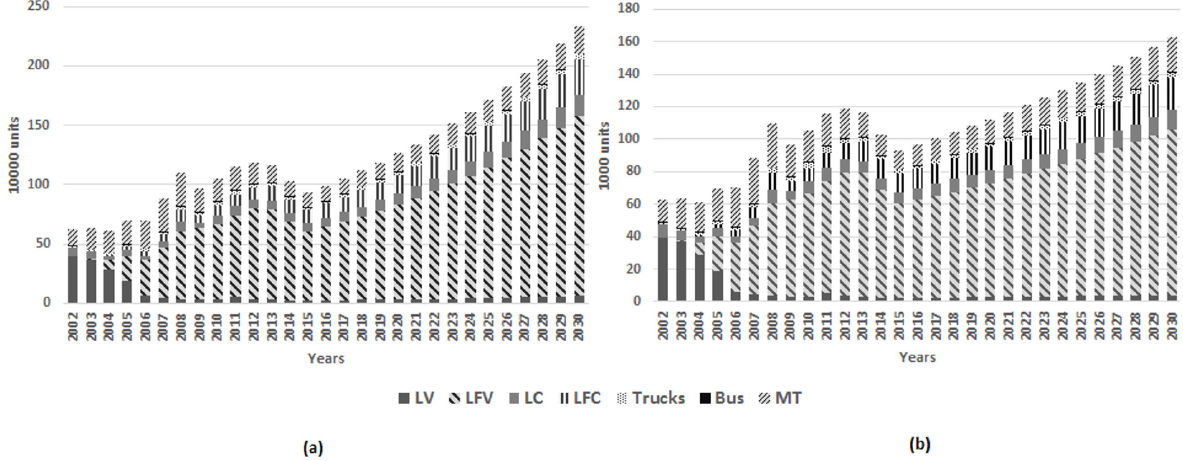
Figure 1 - New licenses for the period between 2002 and 2030. ( a ) With a pessimistic focus. ( b ) With an optimistic